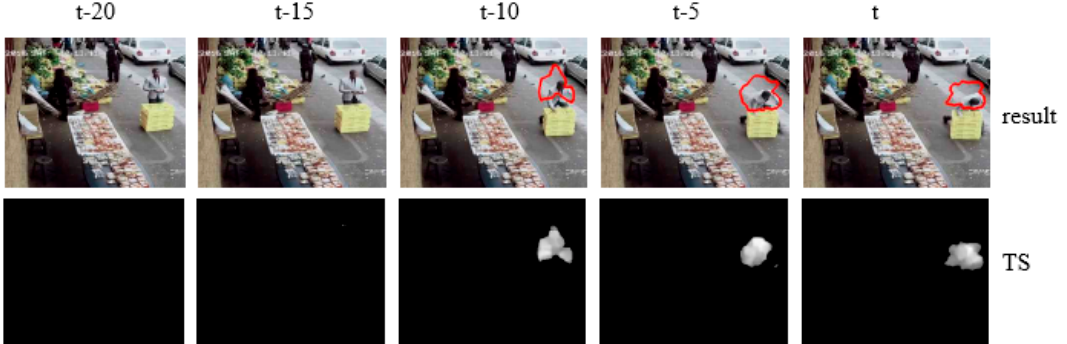
Appl. Sci. 2019 , 9 , x FOR PEER REVIEW Figure 13. Examples of detection results for abnormality from the No. 6 data. Figure 13. Examples of detection results for abnormality from the No. 6 data.